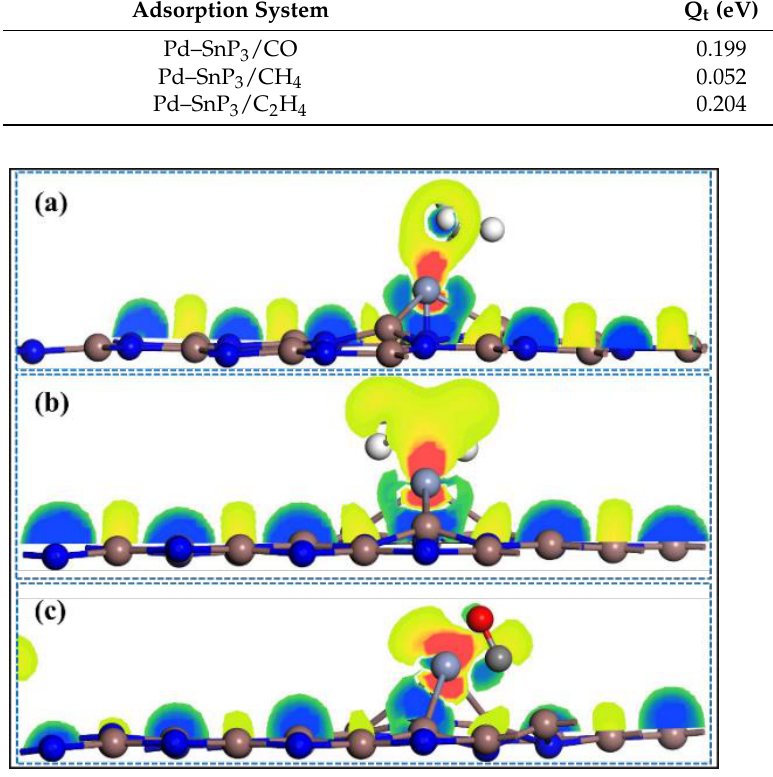
Figure 5. DCD of ( a ) Cr-InN/CH 4 , ( b ) Cr-InN/C 2 H 4 , and ( c ) Cr-InN/CO adsorption systems.